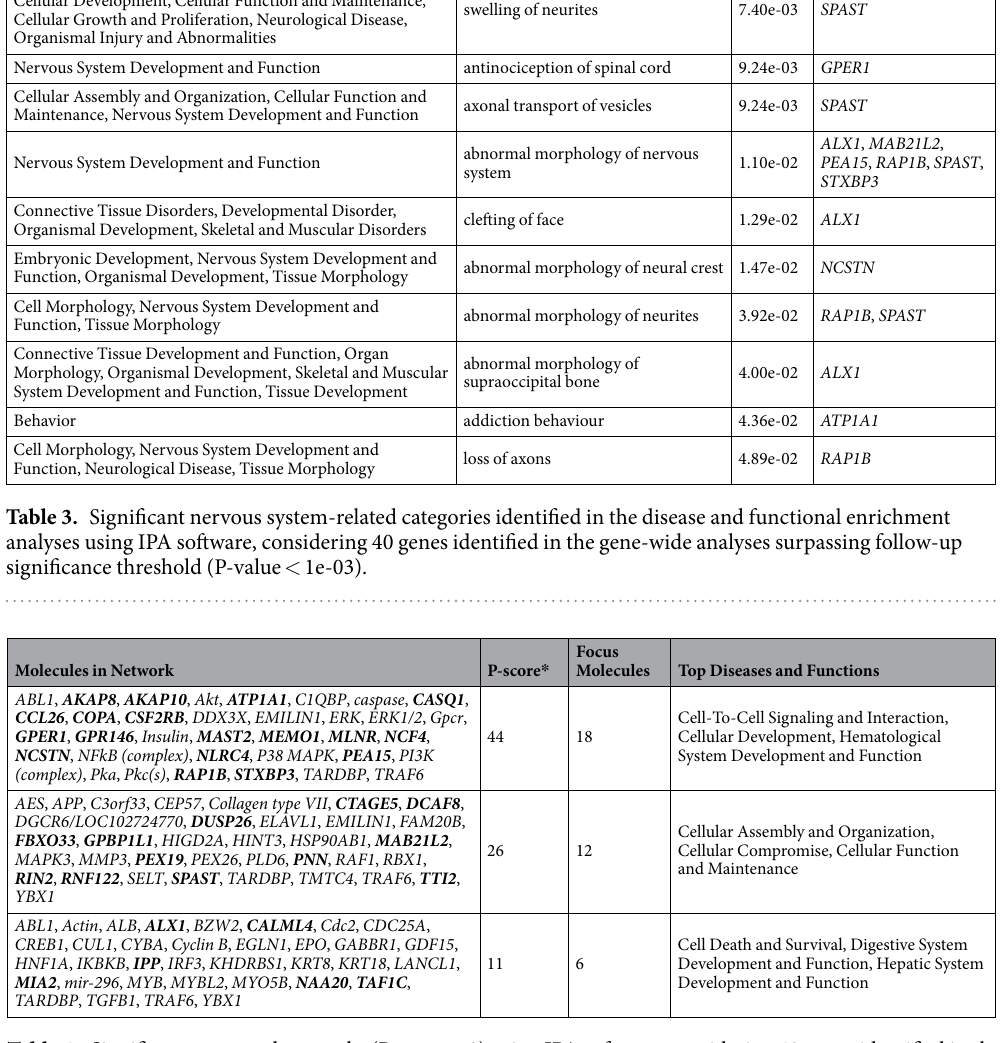
Table 4. Significant generated networks (P-score < 8) using IPA software, considering 40 genes identified in the gene-wide analyses surpassing follow-up significance threshold (P-value < 1e-03). Focus molecules from the follow-up gene-set are shown in bold. * P-score = −